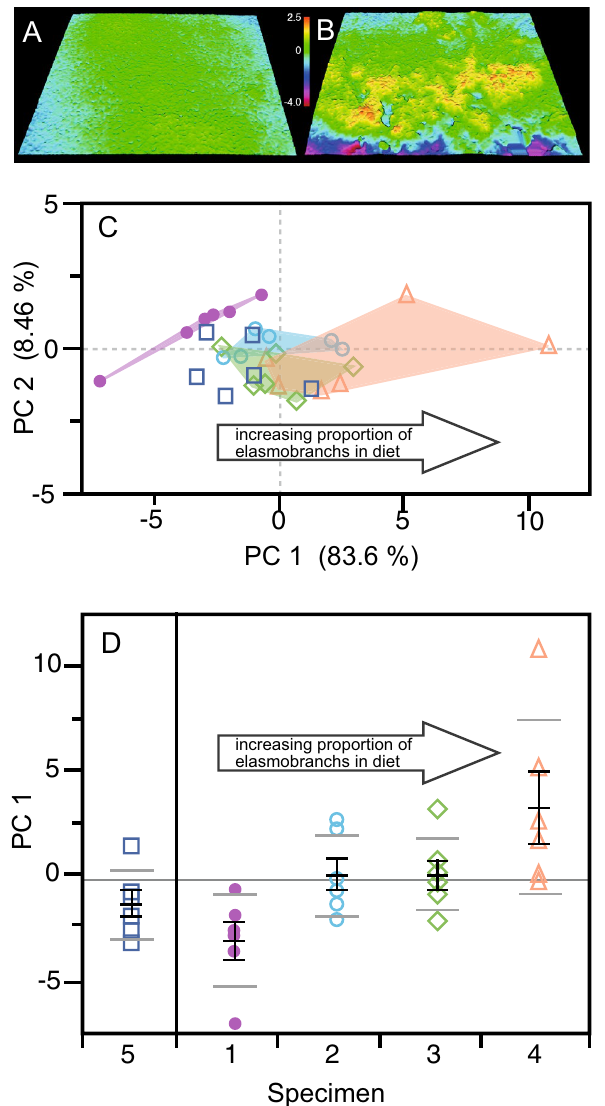
Figure 1. Tooth microwear textures of Carcharias taurus , and principal components analysis of International Organization for Standardization (ISO) texture parameters. A , B Digital elevation models showing levelled surface data (146 µm × 110 µm) for samples from an aquarium fed individual with a fish-only diet ( A specimen 1d: LEIUG 123404), and a wild individual > 2 m in length (in wild populations individuals of this size consume higher proportions of elasmobranchs ( B specimen 4:CT001). C PCA of 14 ISO parameters that exhibit significant pairwise differences between elasmobranchs with different diets. PC1 is strongly correlated with diet, with higher scores linked to wild individuals which, based on available evidence 30–32 , consumed higher proportions of elasmobranch prey in the diet, and a greater range of prey types. Figure is based on data from specimens 1–4. D PCA scores by specimen, showing mean and standard error (black bars) and 95% confidence intervals on means; Horizontal line across plot in grand mean. Both means and variances of PC1 values are correlated with diet (Rs = 1). Specimen 5, with unknown diet, displays PC1 scores most similar to those of individuals with a teleost dominated